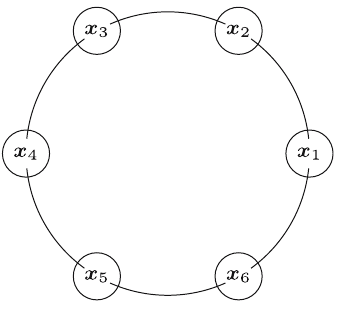
Figure 2: A ring topology with six